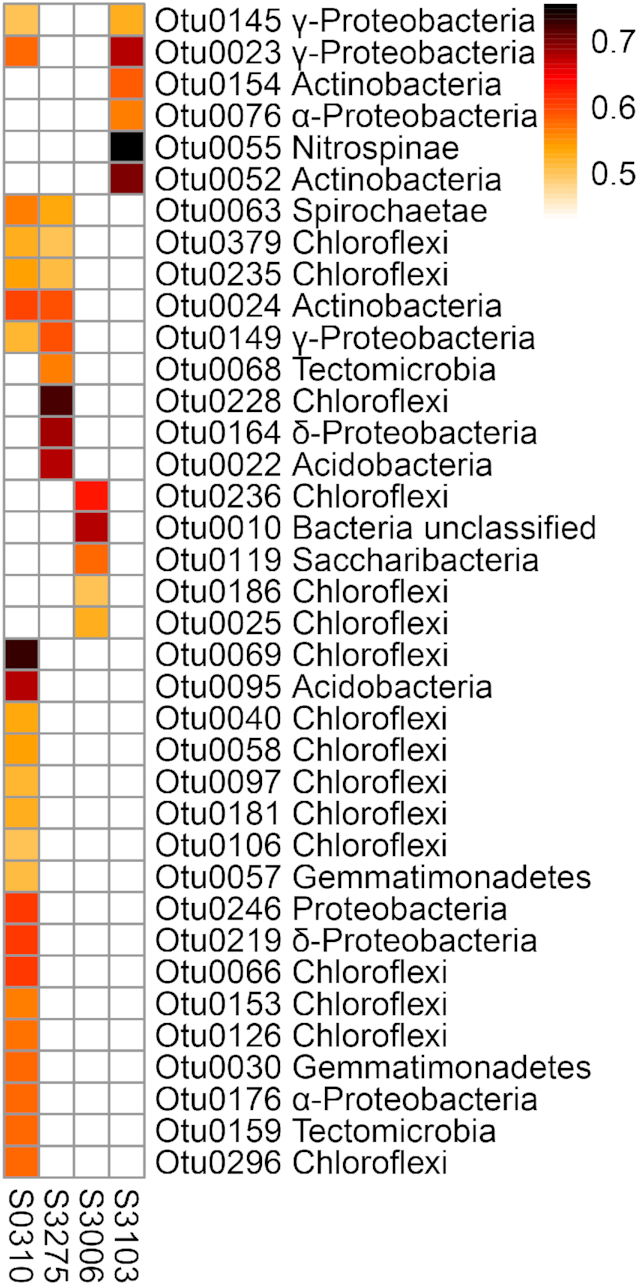
Heatmap displaying significant (Spearman r > 0.5, P< 0.05) co-occurance correlations of tryptophan halogenases (columns) and bacterial 16S rRNA gene OTUs (rows) shared between all Caribbean Aplysina species. OTU IDs and phyla are given to identify bacterial taxa. Columns and rows are clustered by Euclidian distance. Colors indicate correlation coefficients ranging from 0.5 (orange) to 1 (black).